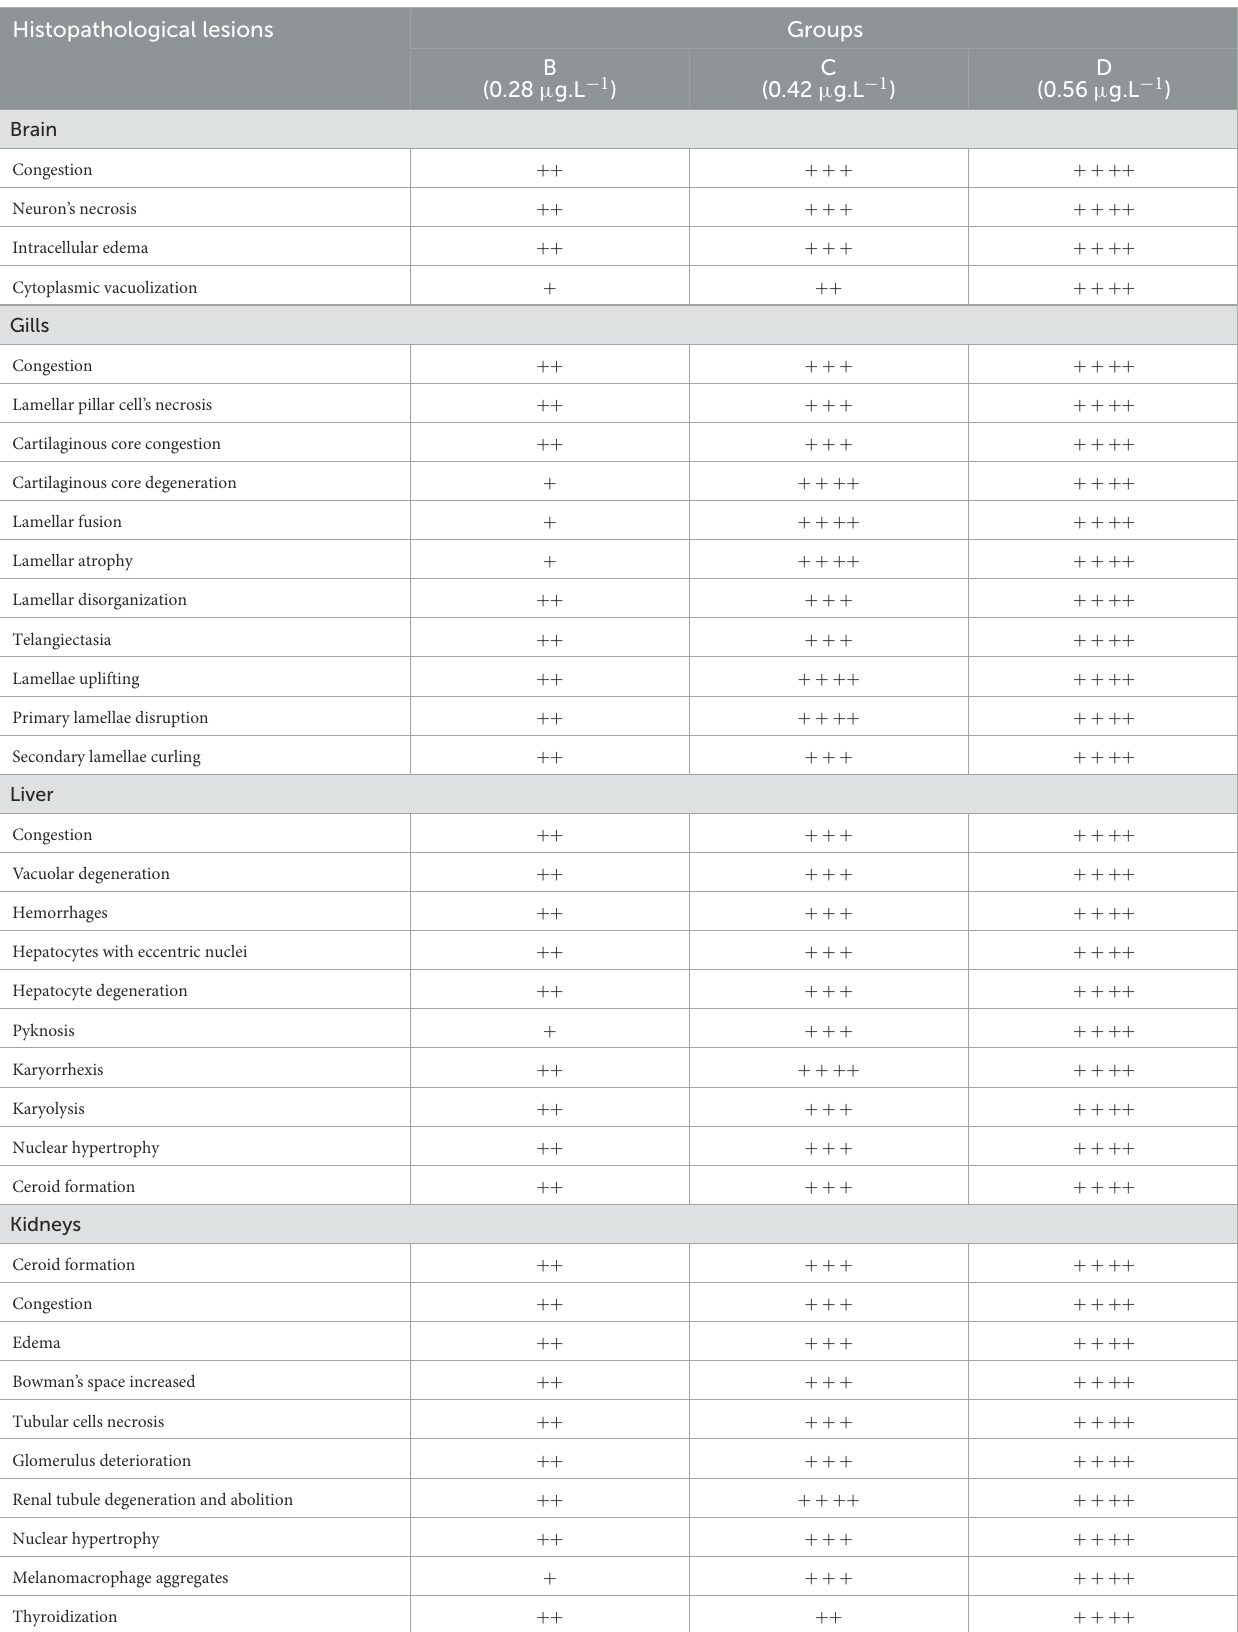
TABLE 9 Severity/degree of different histopathological changes in various tissues of Labeo rohita exposed to different concentrations of copper sulfate at day 36. Histopathological lesions